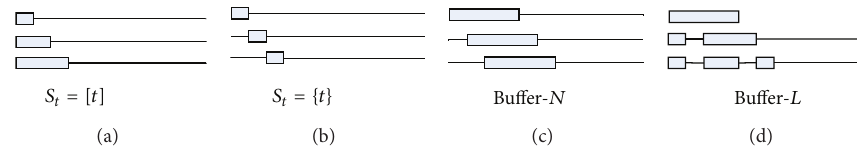
Figure 2: Four choices of 𝑆 𝑡 to update multiple dual coefficient vectors. The horizontal thin line on each learning round represents the whole training data sequence, while the thick boxes represent the set of examples whose dual coefficient vectors are used to ascend the dual function on that round. Essentially, different choices of 𝑆 𝑡 construct different QP problems on each learning round. Obviously, if 𝑆 𝑡 = [𝑡] , the update scheme chooses to solve the largest possible QP on each learning round; and if 𝑆 𝑡 = {𝑡} , the update scheme chooses to solve the smallest possible QP on each learning